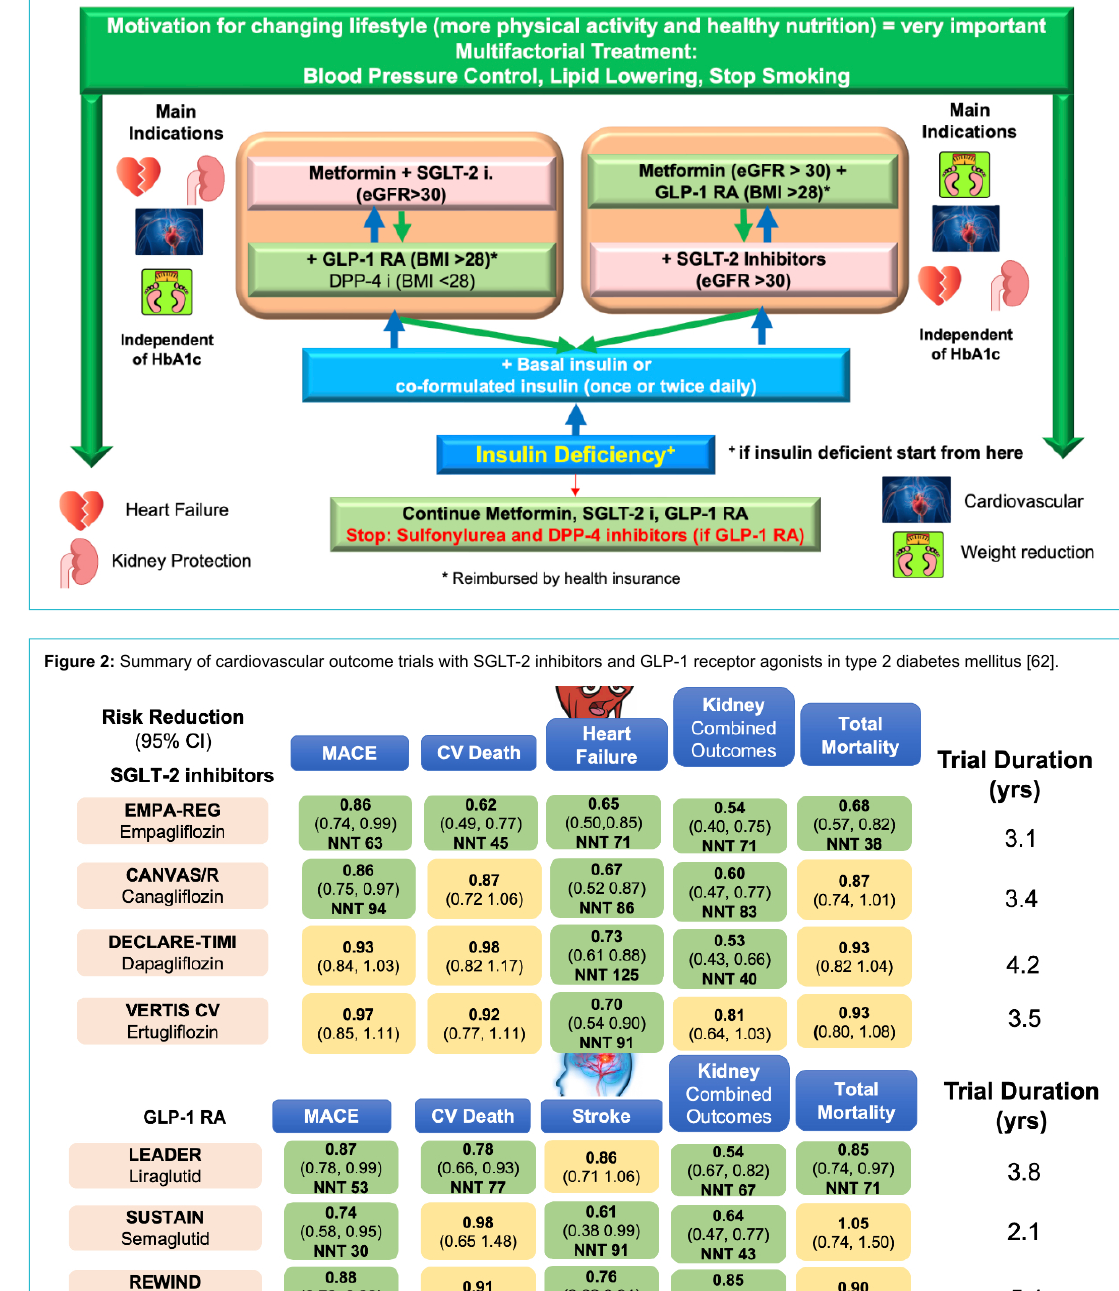
Figure 1: Flow chart of the updated 2023 recommendations at a glance. Co-formulated insulin: Ultra-long-acting insulin Degludec (70%) and short-acting insulin Aspart (30%).